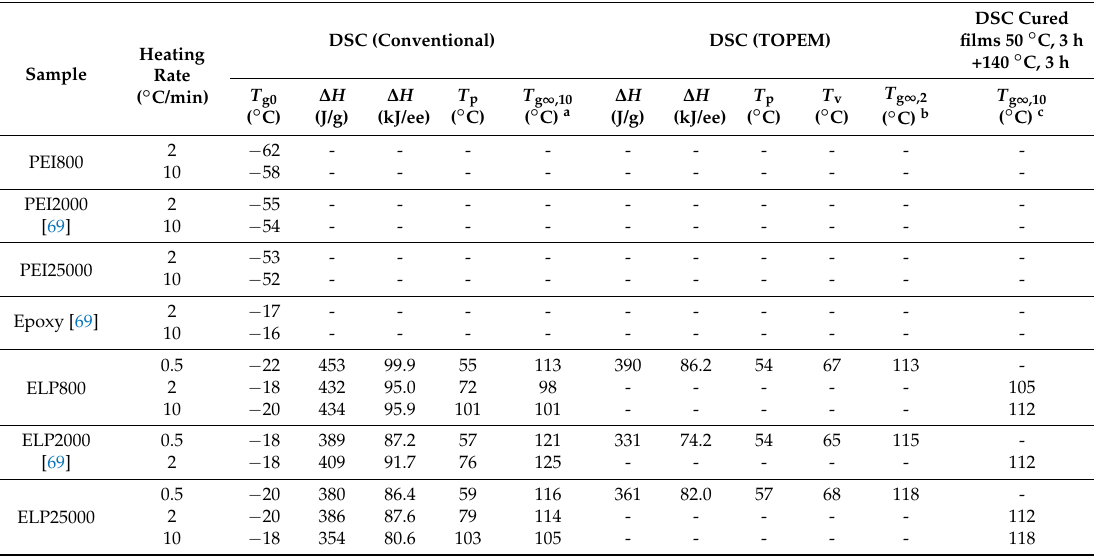
Table 2. DSC results for the HBPs, PEI800, PEI25000, and PEI2000, and for the ELP800, ELP25000, and ELP2000 systems (HBPEI + epoxy resin) at different heating rates.